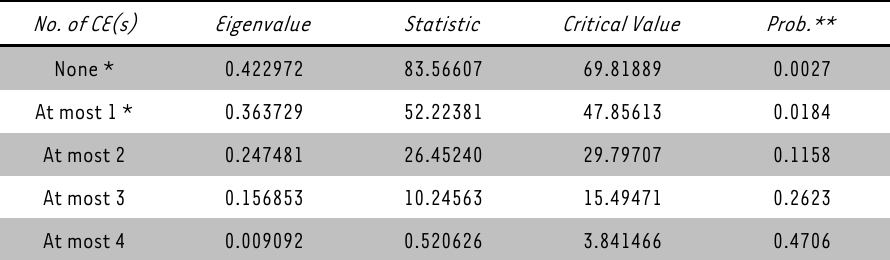
TABLE 3: Cointegration test results No. of CE(s) Eigenvalue Statistic Critical Value Prob.** None *